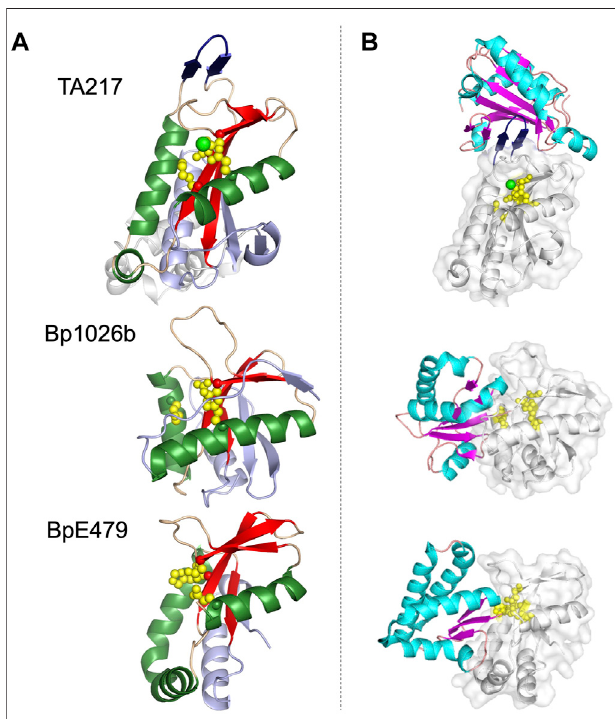
FIGURE3| RepresentativestructuresofthePD-(D/E)XKfamilyCdiA-CT toxins and CdiA-CT/CdiI complexes from E. coli TA271 (CdiA-CT/CdiI TA271 ) [PDB ID: 4G6U (Morse et al., 2012)], B. pseudomallei 1026b (CdiA-CT/ CdiI 1026b ) [PDB ID: 4G6V (Morse et al., 2012)], and B. pseudomallei E479 (CdiA-CT/CdiI E479 ) [PDB ID: 5J4A (Johnson et al., 2016b)]. (A) CdiA-CT in cartoon representation with the core PD-(D/E)XK structure colored by secondary structure with β -strands in red, α -helices in green, and loops in wheat, and the remainder of the secondary elements colored in light blue. Notably,thestructureofTA271includesadditionalstructureattheN-terminus (gray) domain, aZn 2+ ion(green sphere), and the TA271 core isinterrupted by a protruding β -hairpin (dark blue). (B) Structures of PD-(D/E)XK family CdiA- CT/CdiI complexes. CdiI is colored by secondary structure: β -strands in magenta, α -helices in cyan, and loops in salmon. CdiA-CT is in white cartoon representation with a semi-transparent molecular surface and active site residuesshownasyellowspheres.IntheTA271complextheboundmetalion andtheTA271 β -hairpinarecoloredasinthetoxinalone.TheextraN-terminal region of TA271 is